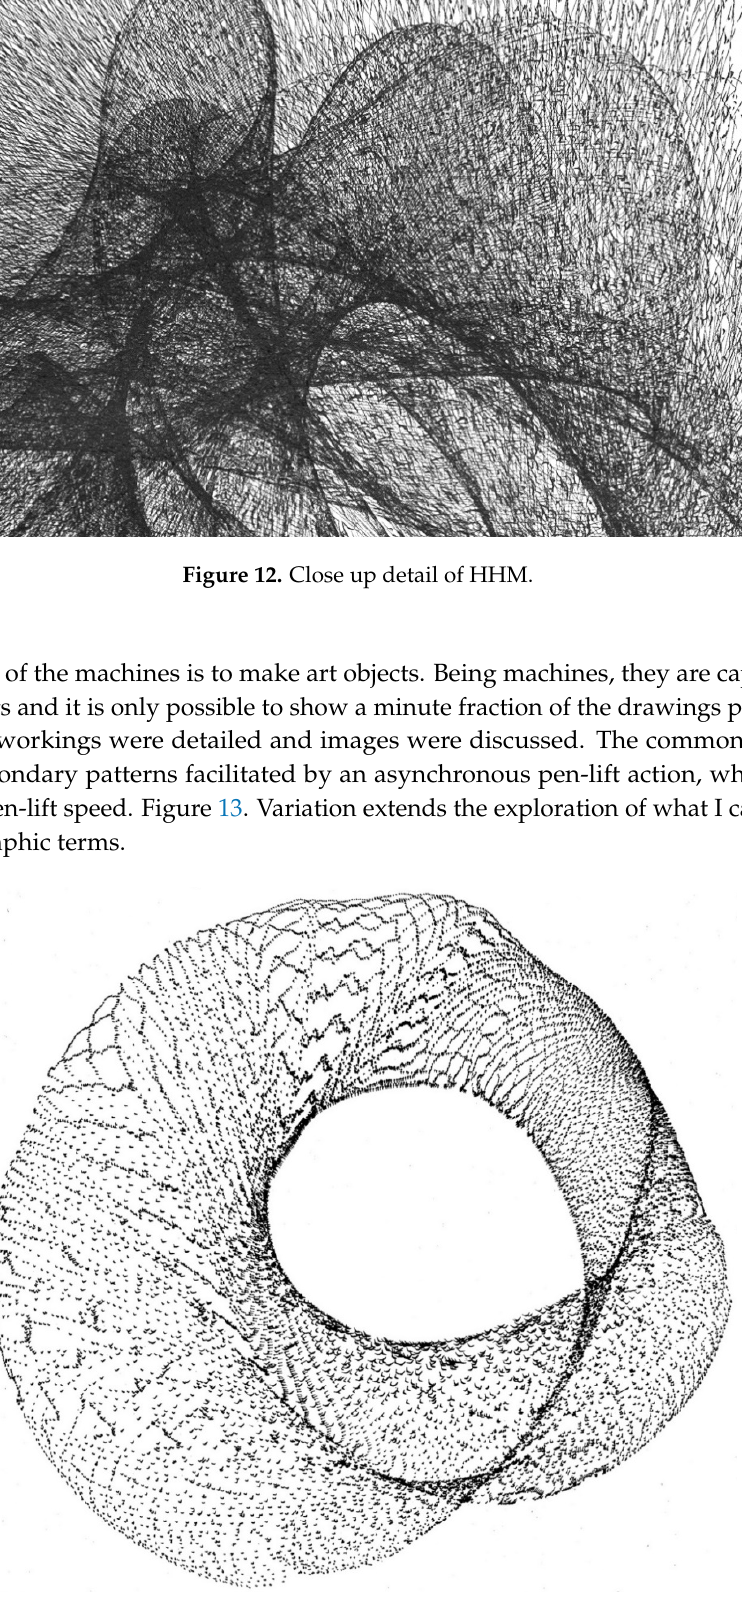
Figures 13. Secondary patterns near chaos from HHM machine with a higher speed pen ‐ lift.